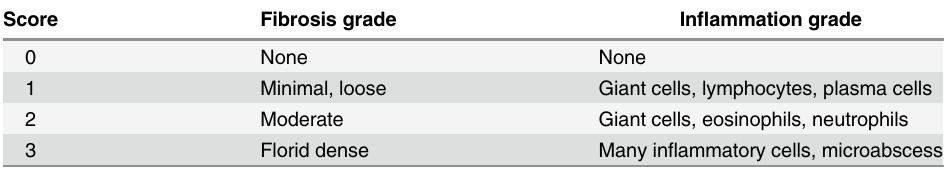
Table 2. Microscopic Adhesion Score